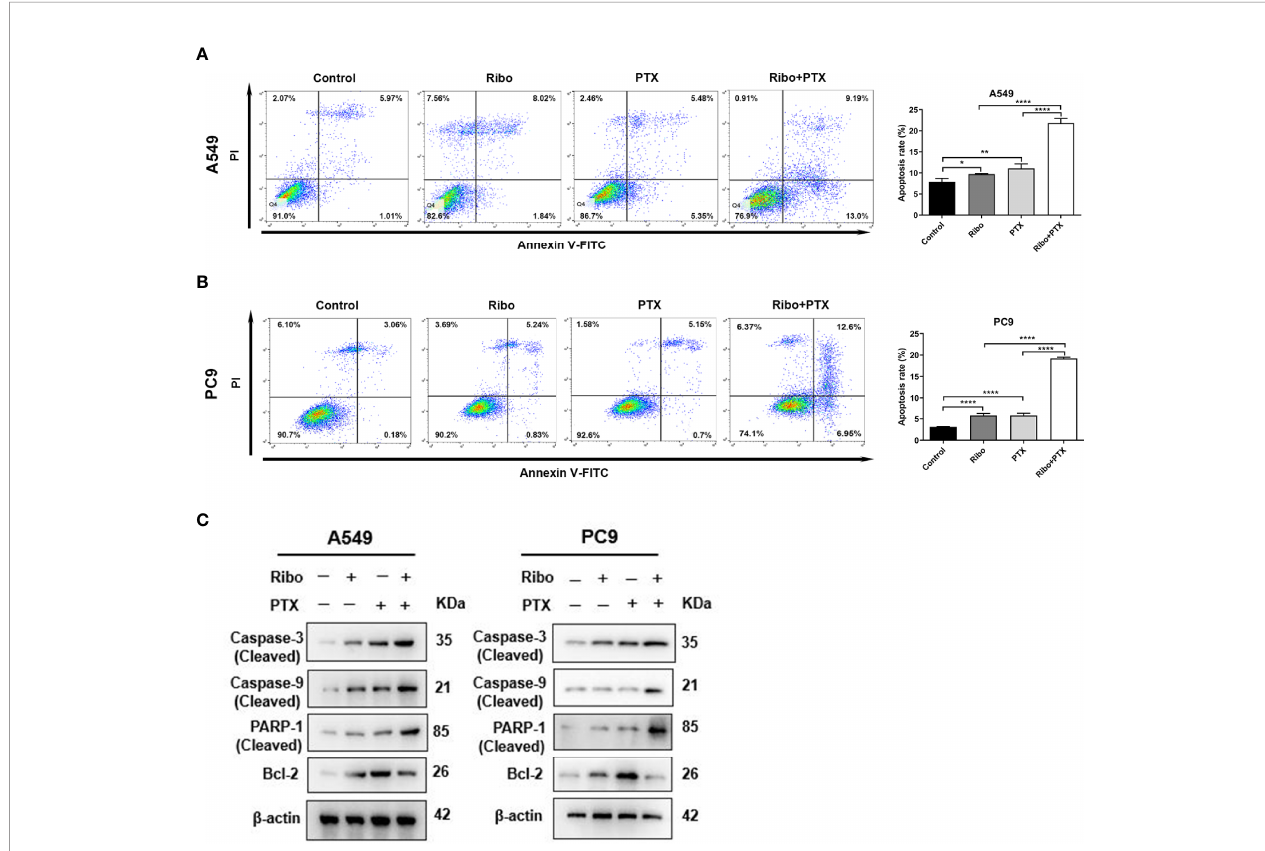
FIGURE 3 | The effect of ribociclib plus pemetrexed on inducing apoptosis of A549 and PC9 cells in vitro. (A, B) A549 and PC9 cells were treated with ribociclib with or without pemetrexed. The quantitative analysis was shown in the bar graphs. (C) The levels of the apoptosis-related proteins were analyzed using western blotting in A549 and PC9 cells treated with or without ribociclib with or without pemetrexed. Data are presented as mean ± SD of triplicate experiments (*p < 0.05, **p < 0.01, ****p < 0.0001). SD, standard